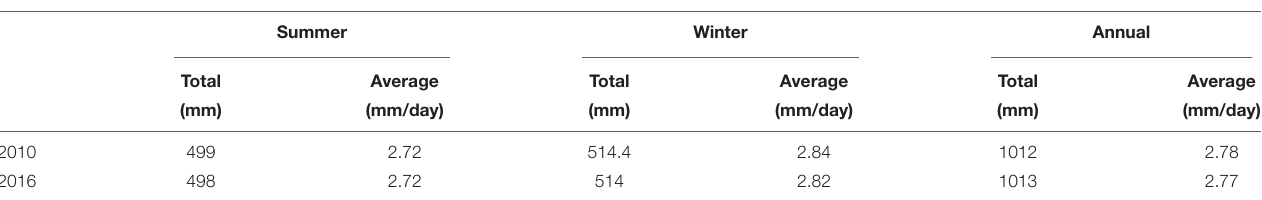
TABLE 1 | Total and average rainfall, by season and per year, for 2010 and 2016. Summer Winter